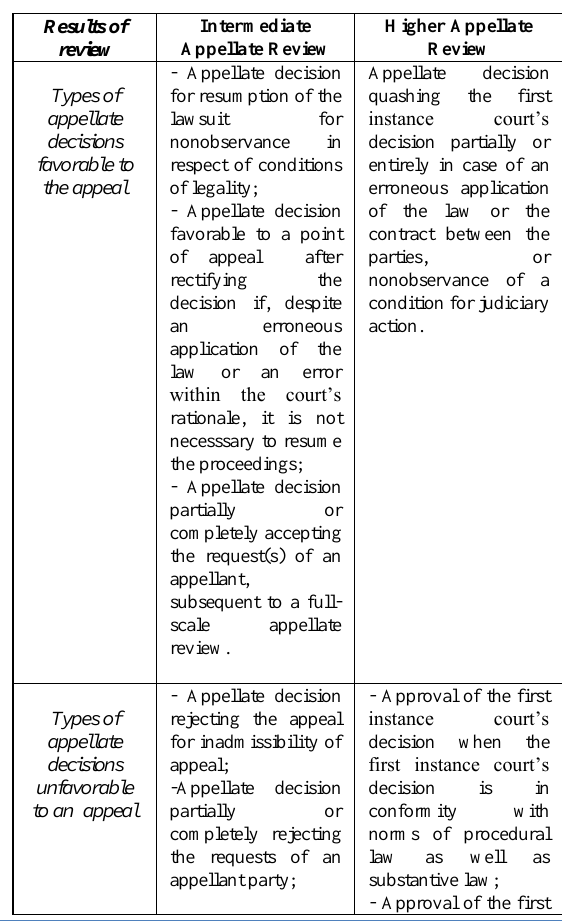
Table 8. Types of Appellate